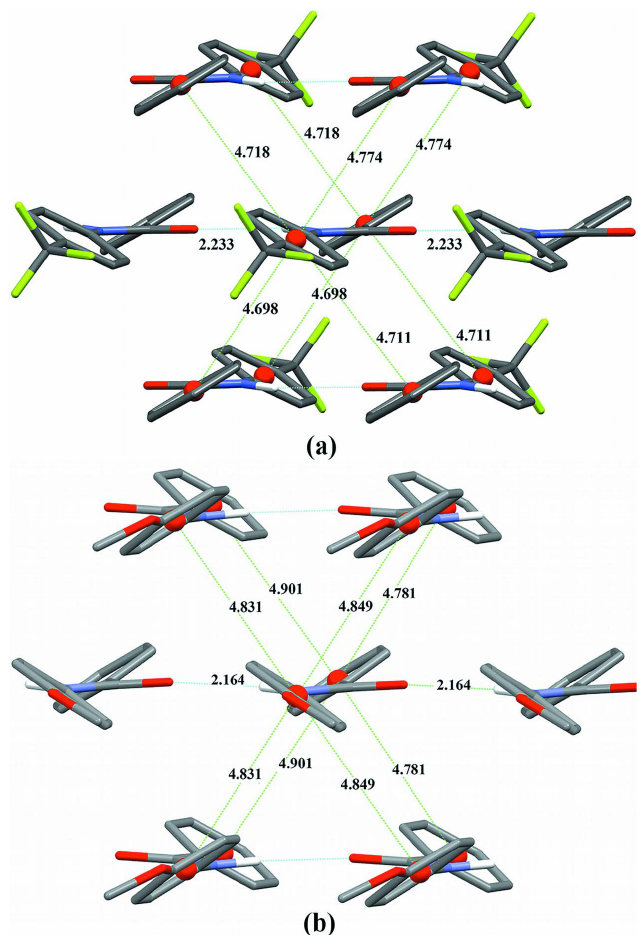
Figure 6 Hydrogen bonding and (cid:2) -stacking (in A˚ ) in ( a ) TFMP and ( b ) MOP (s.u.’s for centroid distances are approximately 0.005 A˚ ). Riding H atoms are omitted for clarity.